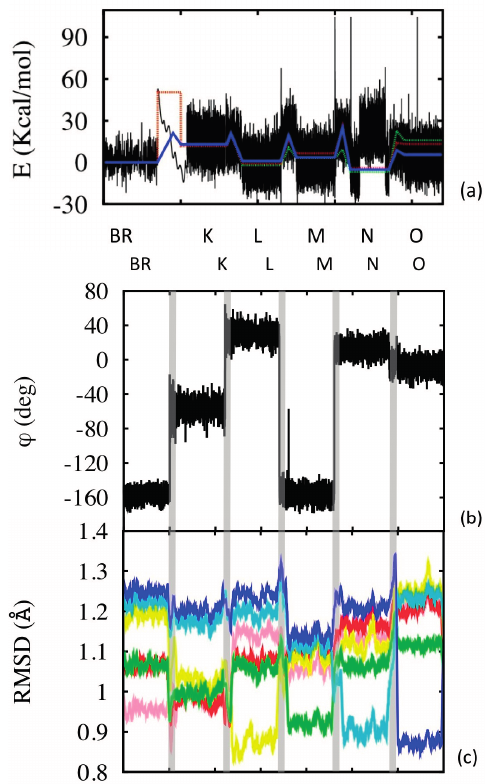
Figure 6. Photocycle simulations. ( a ) Configurational energy along the simulation (black line), and its average within the corresponding simulation segment (blue line). The simulation segments have different time lengths: the equilibrium state simulations are 50 ns long (2 μ s in the case of BR, but only 50 ns are shown, see Supplementary Information for the complete simulation). The BR → K segment is 0.1 ps long, while the other transition segments are 10 ps long (the x axis scale is not proportional to the real simulation time, but enlarged according to visualization needs). Potential energies were aligned in pairs of subsequent states (or transition states) using common structures. The dotted lines are experimental values (green at pH = 7 and red at pH = 9). ( b ) Variation of the isomerization angle, evaluated using the four C atoms of the retinal enclosing the 13-bond. ( c ) RSMD evaluated along the simulation with respect to the different reference states (color code: pink with respect to BR, red to K, yellow to L, green to M, cyan to N and blue to O). The time scale of (b) and (c) does not correspond to that of (a), although the sequence of states is the same for the two (as indicated). The vertical grey bands separate the states and indicate the